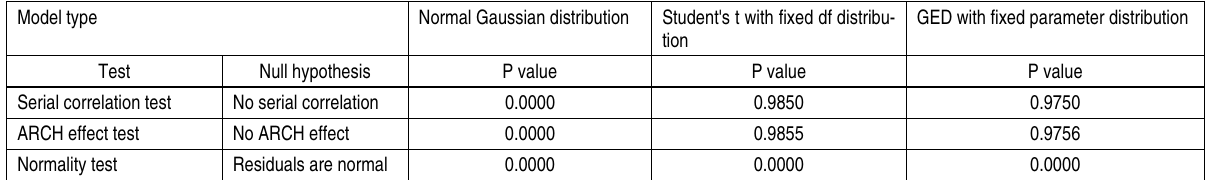
Table 3. Result of model selection for the GARCH